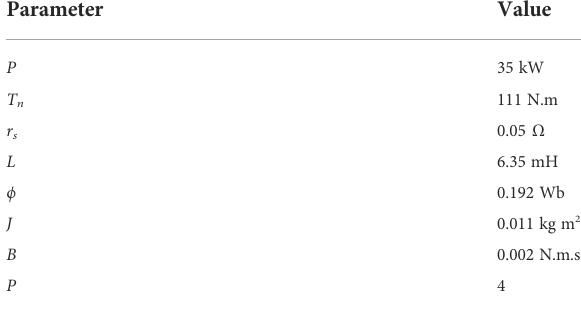
FIGURE 4 Electrical supercapacitor equivalent model.